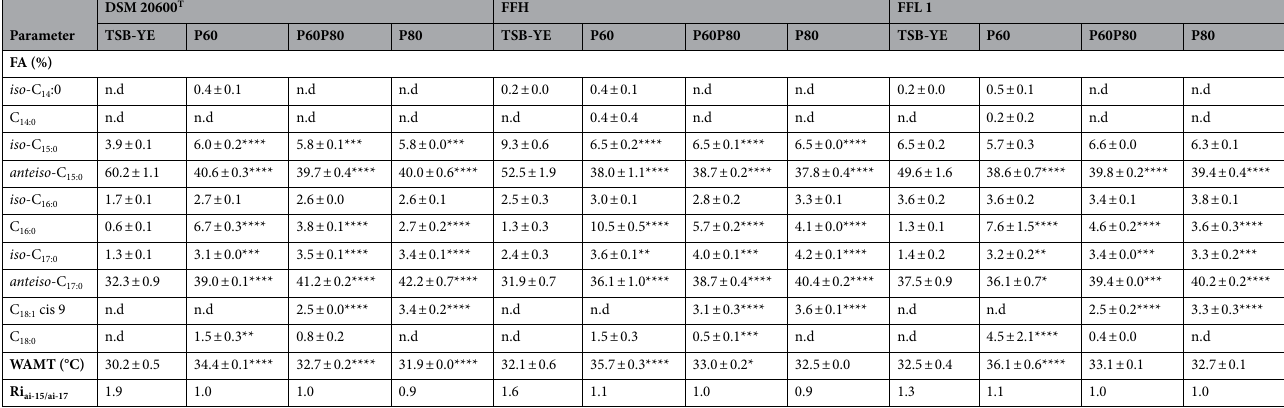
Table 2. Fatty acid (FA) composition, weighted-average melting temperature (WAMT), and the ratio of anteiso -C 15:0 to anteiso -C 17:0 (Ri ai-15/ai-17 ). Listeria monocytogenes strains DSM 20600 T , FFH, and FFL 1 grown at 37 °C in tryptic soy broth-yeast extract medium without supplementation (TSB-YE), with 0.1% (wt/vol) polysorbate 60 (P60), with 0.05% (wt/vol) each of polysorbate 60 and polysorbate 80 (P60P80), and with 0.1% (wt/vol) polysorbate 80 (P80). Values are means ± standard deviation ( n = 3). Asterisks represent